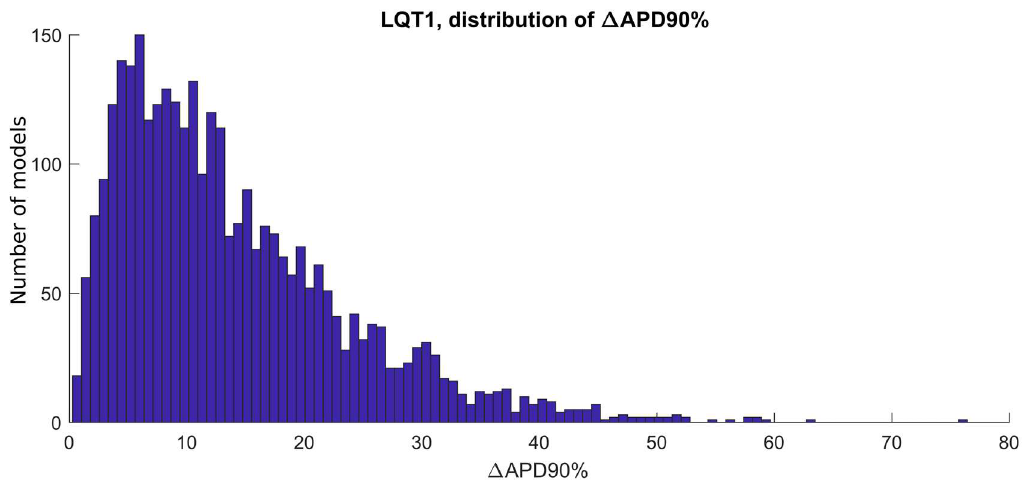
Figure 4. Distribution of the APD 90 changes due to LQT1 in spontaneous APs, expressed as percent of the APD 90 control value. The average ΔAPD 90 % is +14%.